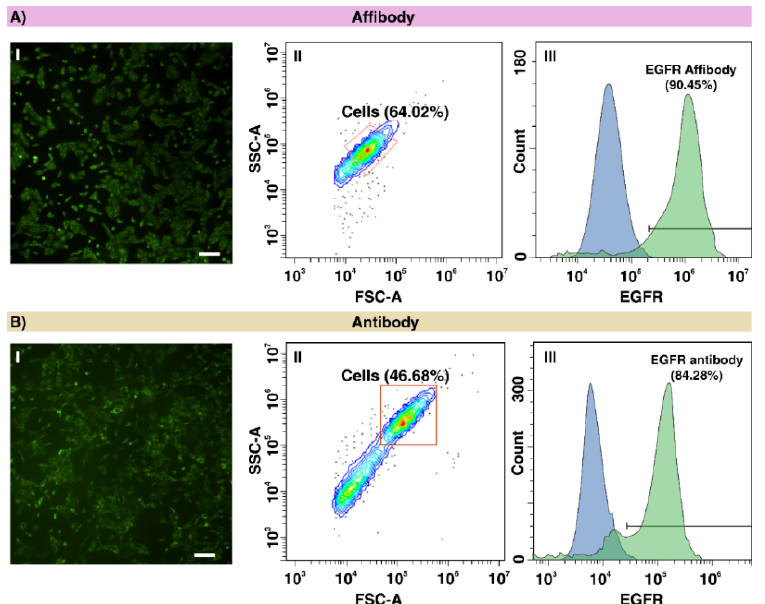
Figure 2. A ) Fluorescence microscopy images of A549 cells stained with I anti-EGFR-FITC Affibody using a FITC filter, II the flow cytometry dot-plot scatter and III the flow cytometry histogram overlay of the A549 cells stained with anti-EGFR-FITC Affibody. ( B ) Fluorescence microscopy images of A549 cells stained with I anti-EGFR-Alexa Fluor 488 antibody using a FITC filter, II the dot-plot scatter and III the flow cytometry histogram overlay of the A549 cells stained with anti-EGFR-Alexa Fluor 488 antibody (scale bar: 200 µm).